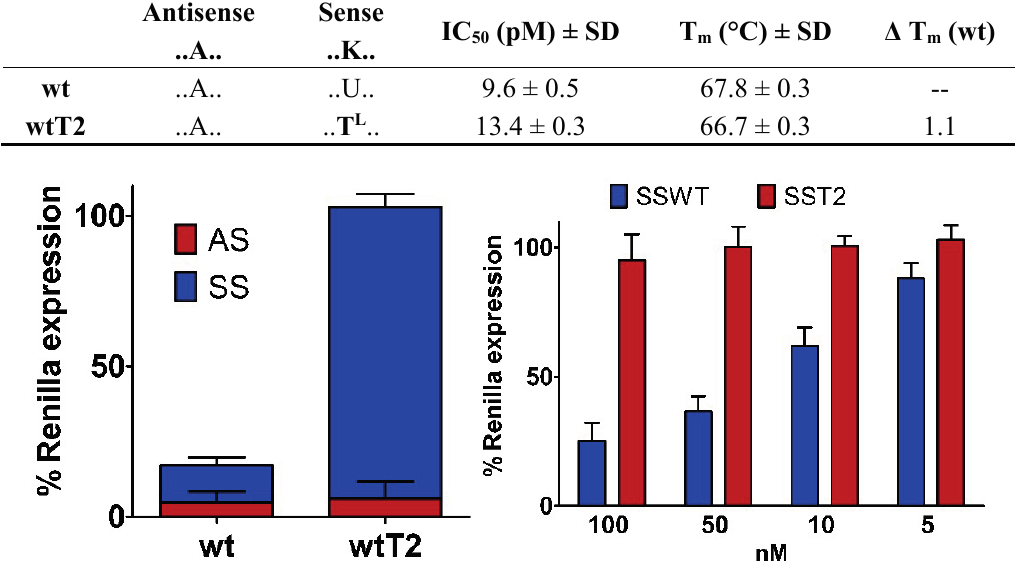
Figure 7. (left panel) ON-/OFF-target silencing of L -threoninol modified siRNA. Unmodified ( wt ) and modified at position 2 of the sense strand ( wtT2 ) siRNAs, at final concentration of 1 nM, were co-transfected with psiCHECK2 sensors ( AS and SS ) in HeLa cells. Mock transfection was set as 100%. n = 3 ± SD. (right panel) Silencing activities of unmodified ( SSWT ) and position 2 T L -modified ( SST2 ) sense ss-siRNA in HeLa cells. Luminescence were determined 24 h after the co-trasfection of decreasing concentrations of ss-siRNAs (100 nM, 50 nM, 30 nM and 5 nM) with psiCHECK2 ( SS ) reporter. Mock trasfection was set as 100%. n = 3 ±